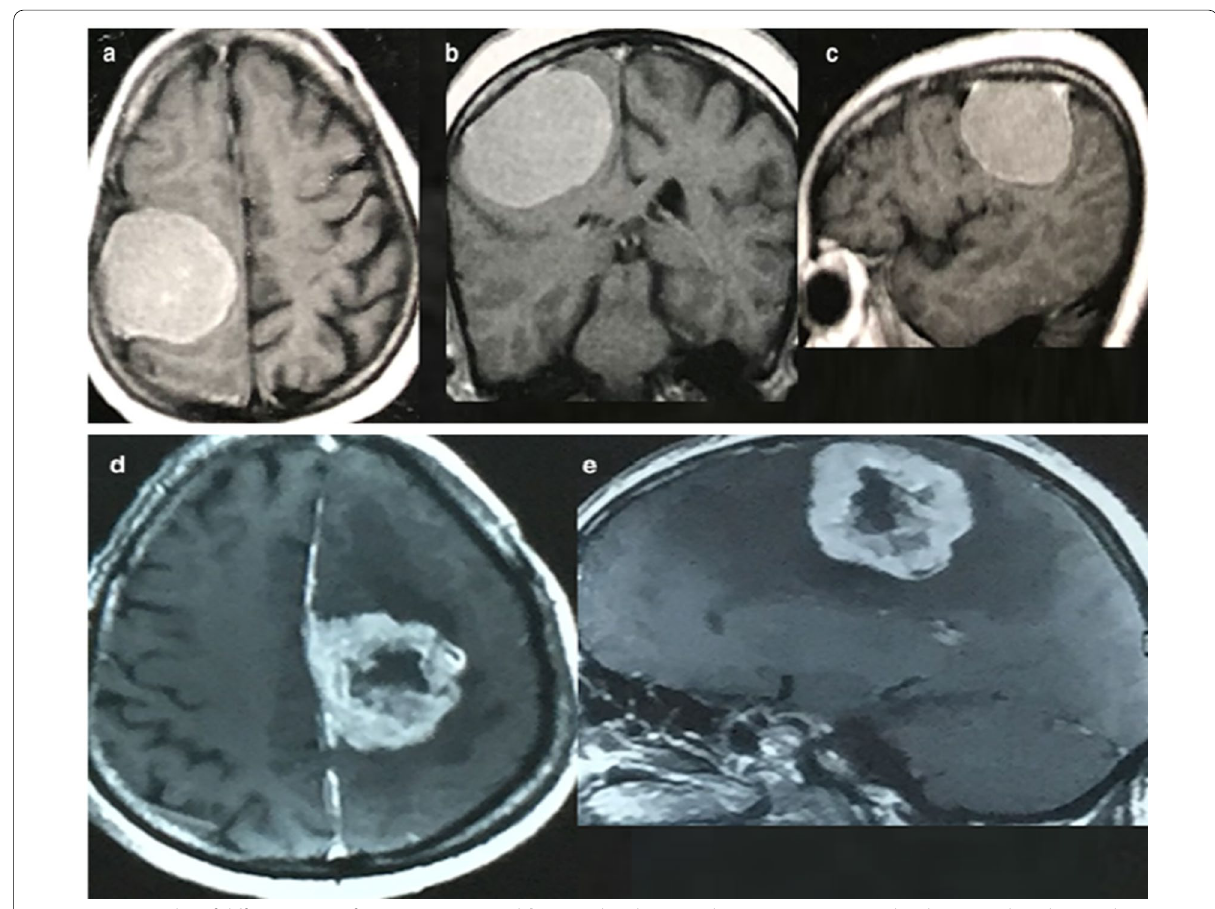
Fig. 3 MRI examples of different types of meningioma: a axial, b coronal and c Sagittal post-contrast T1 weighted images, show large right convexity, well defined, homogenously enhanced meningioma. Histopathology revealed transitional meningioma (WHO grade I). d Axial and e Sagittal post-contrast T1WI: a left well defined lobulated parasagittal extra axial dural based mass (meningioma). It shows avid enhancement with area of central degeneration and associated with moderate vasogenic edema and mass effect evident by effacement of the adjacent sulci and mild midline shift. Histopathology revealed atypical meningioma (WHO grade II)